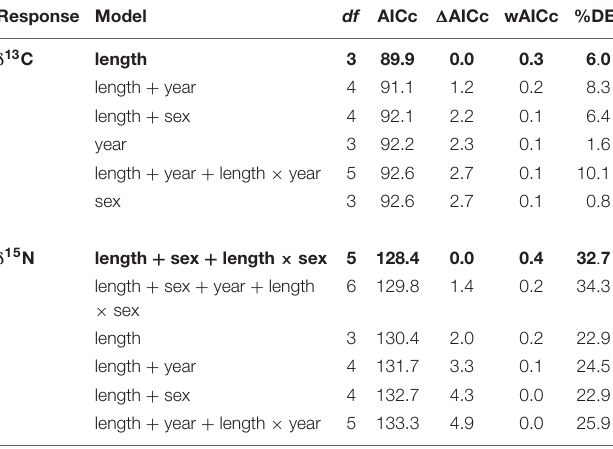
TABLE 2 | Ranked Generalized Linear Models for δ 13 C and δ 15 N values for whale shark dermis. Response